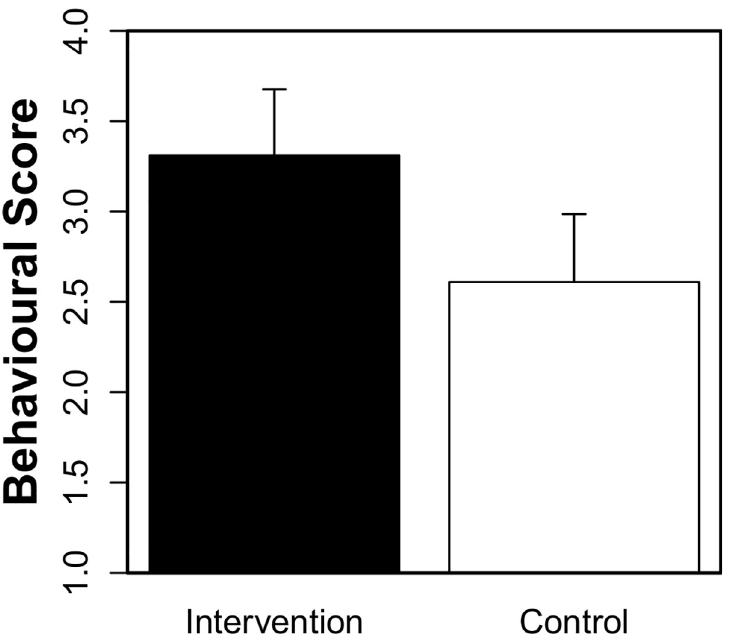
Fig 2. Study 2: Mean (95% CI ) behavioural total scores in the intervention and control groups. The maximum score of 6 reflects engagement in all of the handwashing behaviours observed (i.e., soap, rub, wrists, fingers, nails and